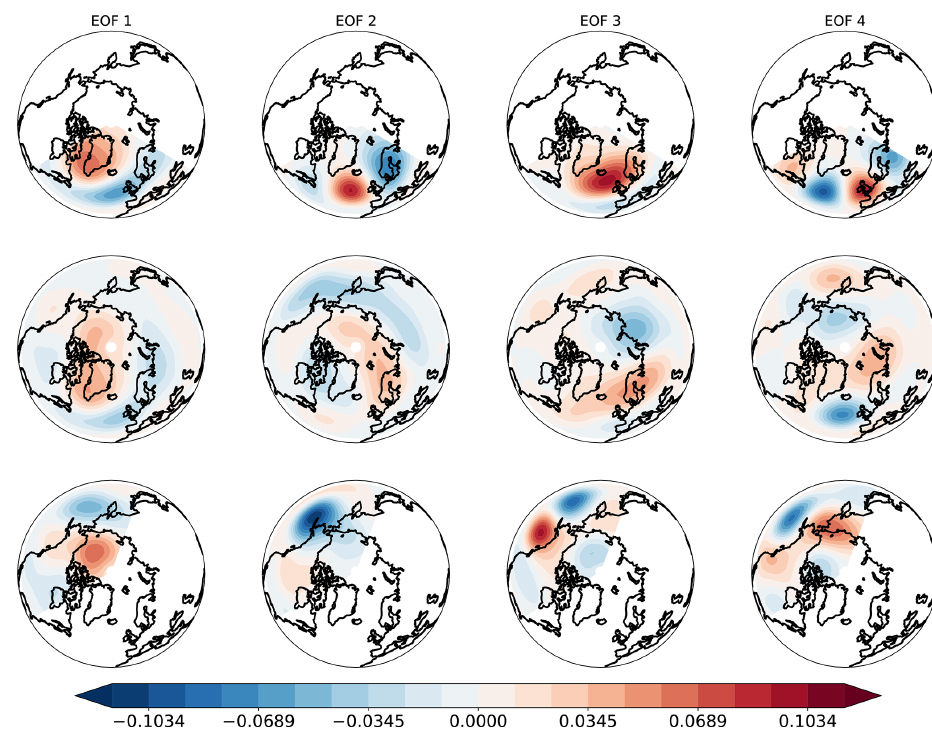
Figure A2. Patterns of the four leading EOFs for JJA: EAT (first row), NH (second), PAC (third).